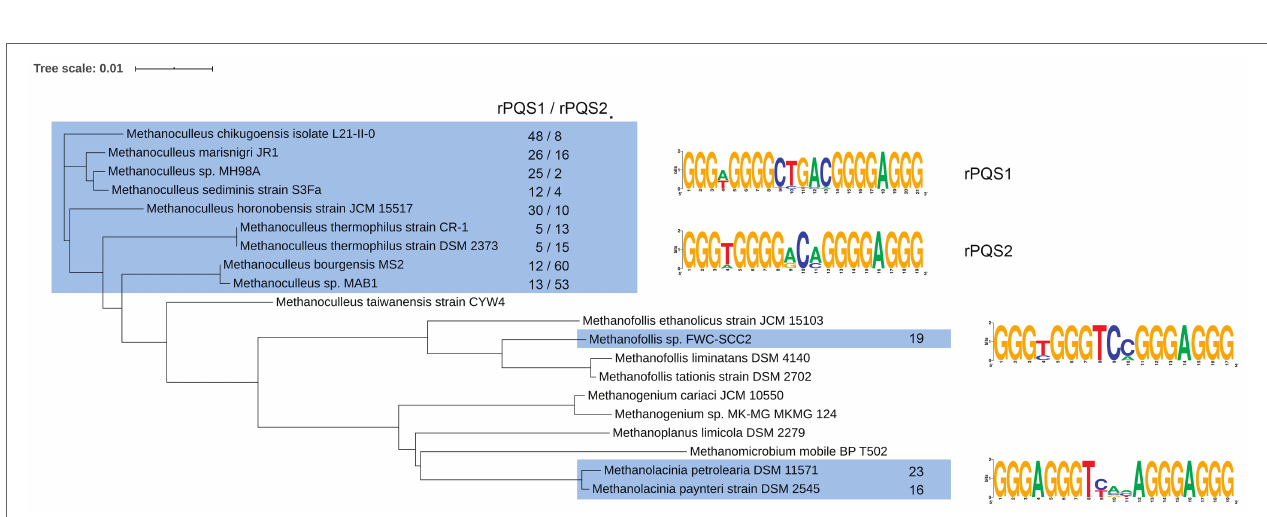
FIGURE 1 | (A) The potential quadruplex sequences (PQS) density in archaeal genomes (black circles) and a random sequence (red squares, error bars shows SD in five 10 Mb replicates for random sequence) plotted against the G/C content of the genomes. (B) PQS density in genomes of Methanomicrobiaceae family. Filled green squares are genomes containing repetitive PQSs; gray circles present the genomes lacking repetitive PQS (rPQS); red square corresponds to Methanogenium cariaci JCM 10550 genome that contains about 100 repeated sequences of the pattern GnNiGn (where n > 7, i = 1 or 2).